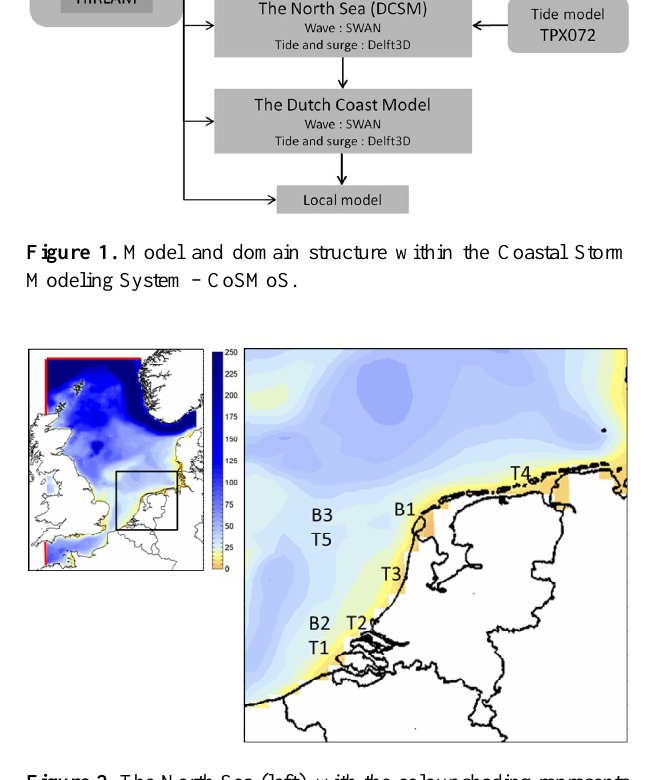
Figure 2. The North Sea (left), with the colour shading represents depth. Red lines indicate the swell boundary for the wave model. The Dutch coast (right), and stations used in analysis (see Table